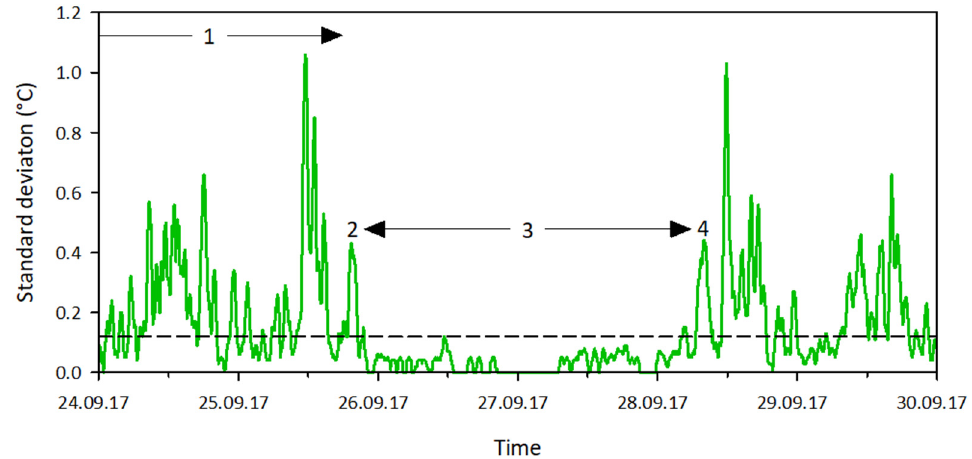
Figure 6. Example of the typical changes in the moving standard deviation of the temperature for wetting and drying sequences. Signals ( 1 ) and ( 3 ) indicate a dry and a wet channel respectively. A state change from a dry to wet channel ( 2 ) is indicated by a peak in the moving standard deviation with a maximum of at least 0.20 °C, followed by a dip below the 0.12 °C threshold (dashed line) for at least 2.5 h. A state change from wet to dry channel ( 4 ) is indicated by a rise in the moving standard deviation above the 0.12 °C threshold, followed by a peak with a maximum of at least 0.20 °C, and a stay above the threshold for at least 3 h. The timing of both state changes coincides with the peaks.